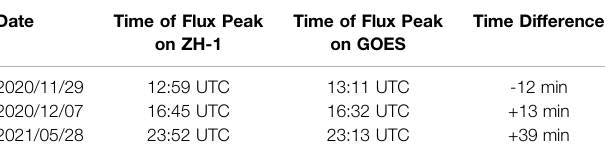
TABLE1| ThetimedifferenceofX-ray fl uxpeakof fl areobservationsbetweenZH- 1 and GOES